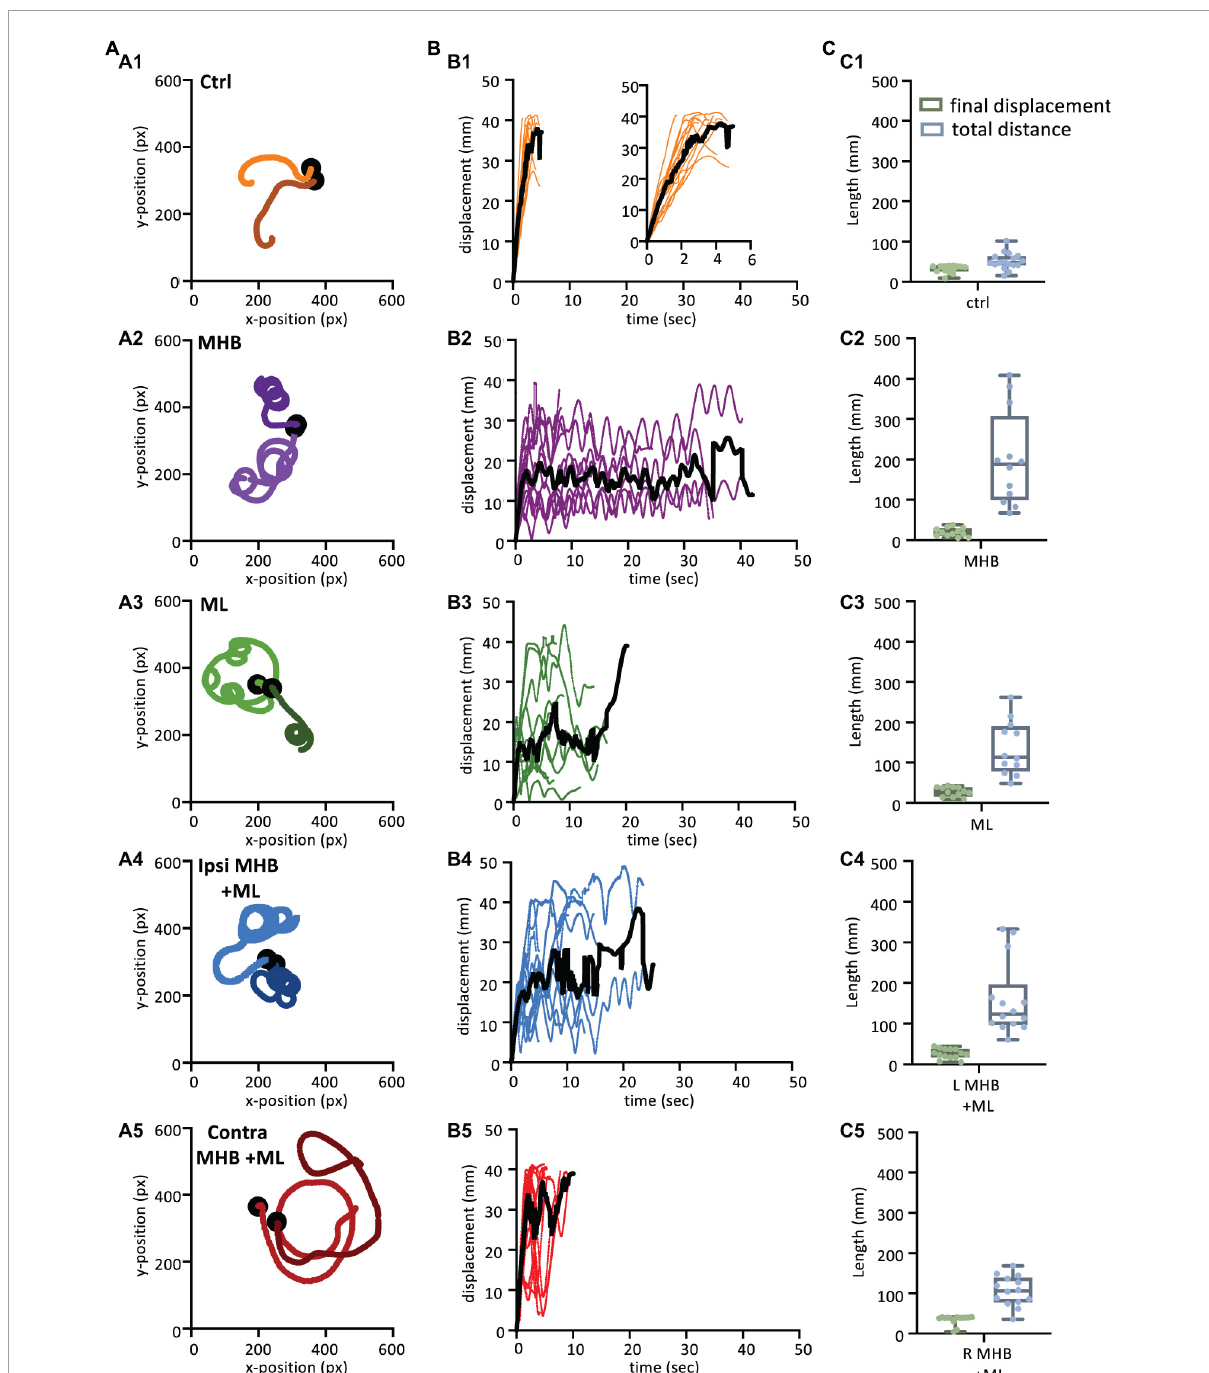
FIGURE5 Midbrain lesions lead to stark changes in the trajectory of tadpole swimming (A) . Example swim trajectories ( n = 2) for each animal group extracted from the FastTrack Software. The starting position is symbolised by the black dot. (B) Displacement time graphs of each animal trial (coloured lines) to show the tadpoles deviation from the starting position for each animal group (See section “Materials and methods” for calculation). The average is represented by the black line for each animals group. An increase in displacement refers to the tadpole swimming away from the starting position, while a decrease represents the tadpole swimming closer to the starting position. (C) Boxplot of the final displacement and total distance travelled for each animal trial within the respective animal group. For panels (B,C) , Control: n = 10, trials = 17; MHB: n = 9, trials = 12; Midline: n = 8, trials = 12; Ipsi MHB + ML: n = 9, trials = 14; Contra MHB + ML: n = 10, trials = 14. For boxplot, single data points are plotted, the middle horizontal line represents the median value, the box represents the interquartile range (IQR, 25–75 percentile), and the extended vertical bars represent the minimum and maximum